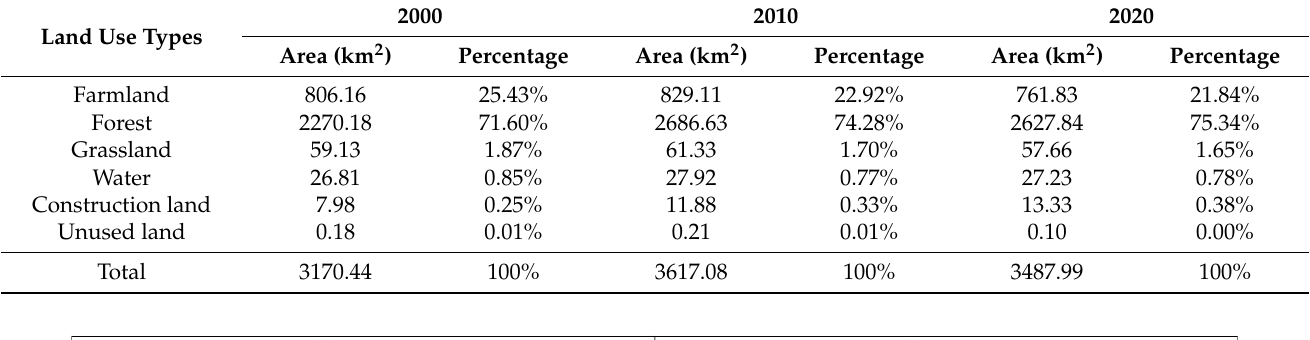
Table 2. Composition of land use types for ecological corridors in 2000, 2010, and 2020.